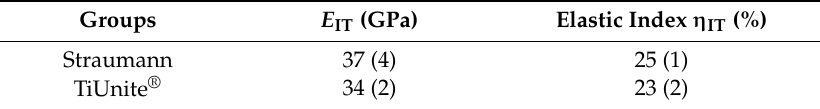
Table 3. Mean values and standard deviations of the mechanical properties tested. There were no statistical differences identified between the groups ( p > 0.05). E IT , indentation modulus; η IT , Elastic index, failed